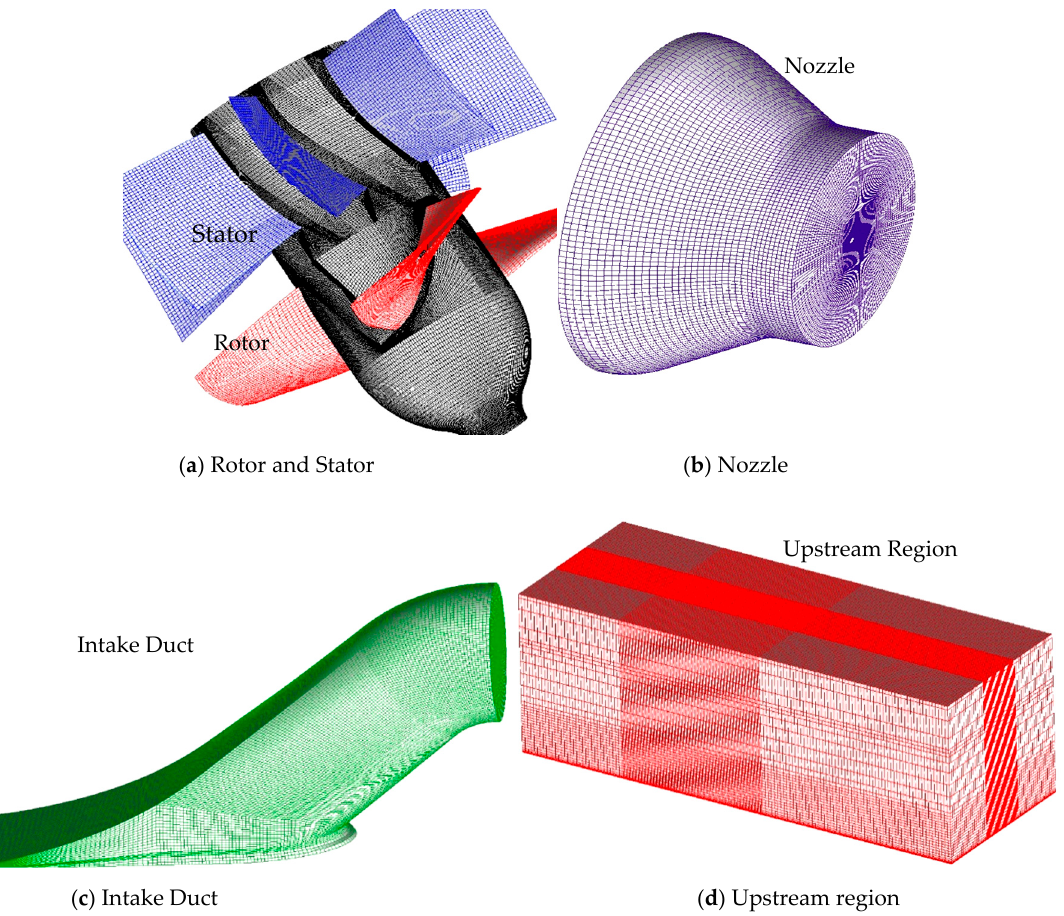
Figure 3. 3D view of multi-block grid in the waterjet pump.